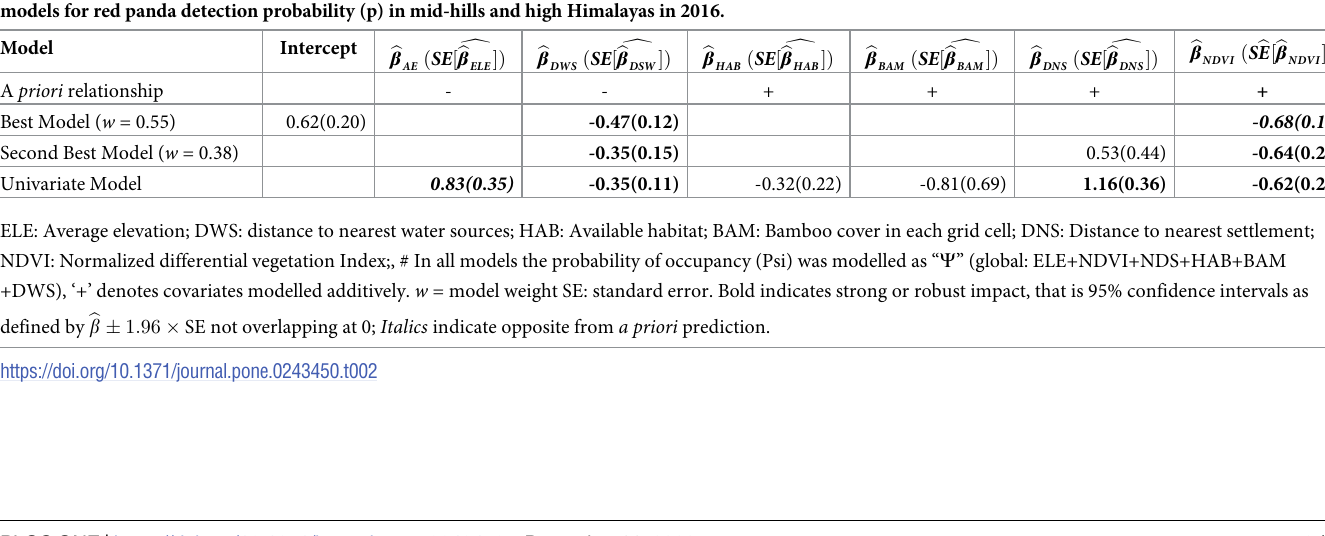
occupancy probabilities. We found the model containing the additive effect of NDVI (detec- tion probability decreases with higher vegetation productivity) and DWS (higher detection probability as it approaches water sources) to be a top detection model (AIC = 852.49, w = 0.55, Table 1). The next competing model (AIC = 853.25, Δ AIC = 0.76, w = 0.38) contain- ing additional covariate DNS as the second-best detection model, such that approaching settle- ments led to higher detection probability. The β estimate coefficients for the covariates influencing detection probabilities had varying degrees of influence and confidence intervals (CIs) did not overlap zero. This indicates support for effects of NDVI and DWS (Table 2) and confirming to our prediction expect for NDVI which was opposite. Elevation range, bamboo cover, and available habitat had no influence ( Δ AIC > 15) on detection, contrary to our pre- dictions. Although we modelled the covariates influencing C using the model structure from the top detection models (NDVI + DWS) fixed, we also used the next best model (NDVI +DWS+DNS, Δ AIC = 0.76) and compared them via AIC.